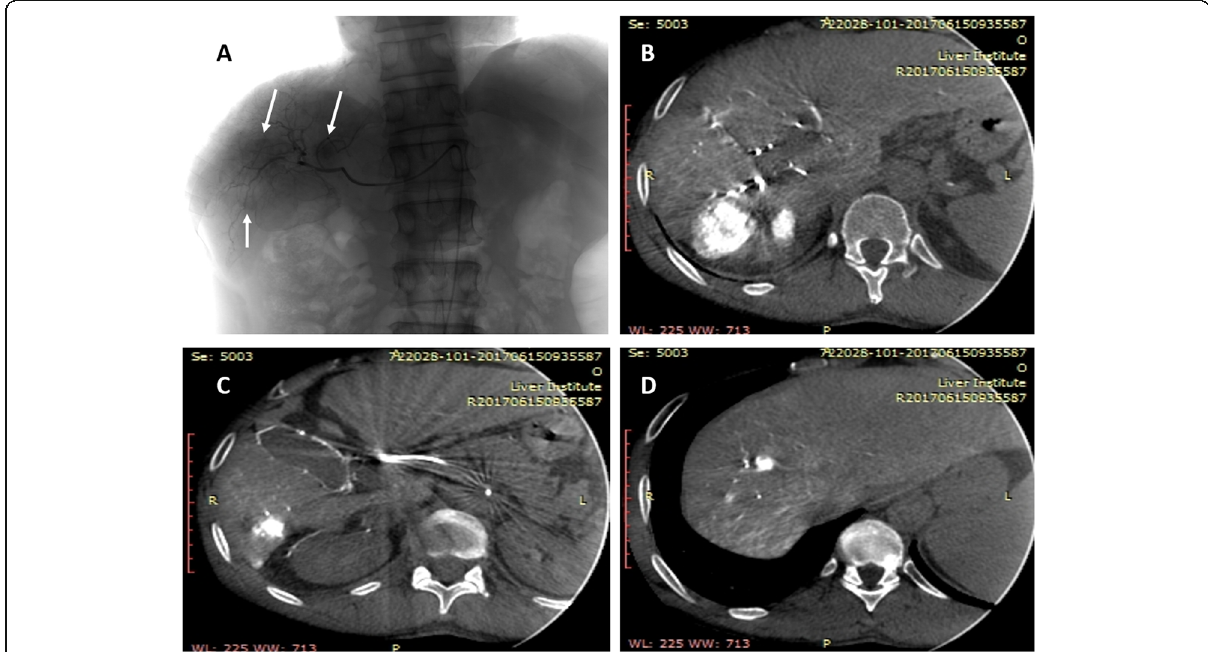
Fig. 1 A 51-year-old male patient with two focal lesions detected by ultrasound and confirmed to be HCC by imaging and laboratory criteria undergoing TACE as a treatment for HCC. a Non-selective angiography of the main right hepatic artery revealing the vascular anatomy of the right hepatic artery up to fourth-order branches and three enhanced focal lesions (arrows) and enhanced gall bladder wall. The size of the smallest lesion was 1.9 cm. b, c Axial CBCT-HA revealing the vascular anatomy of the liver up to the fifth-order branches as well as the lesions that appeared in the angiography. The enhanced gall bladder wall also showed in c . d Axial CBCT-HA at higher cuts revealing two additional smaller lesions. The smallest lesion was 0.8